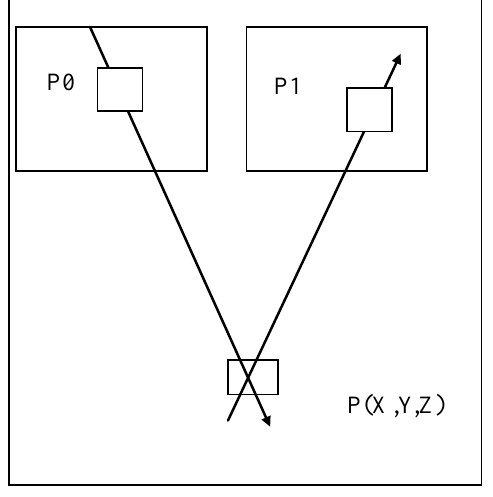
Figure 3.radiant relationship In Region-Based least squares matching, firstly, we calculate three-dimensional coordinates position of the added point P(X,Y,Z)(ZHANG Guo,2011). Then we calculate it back to the matched image. Without the consideration of random noise, the change of the radiation can be described as below.